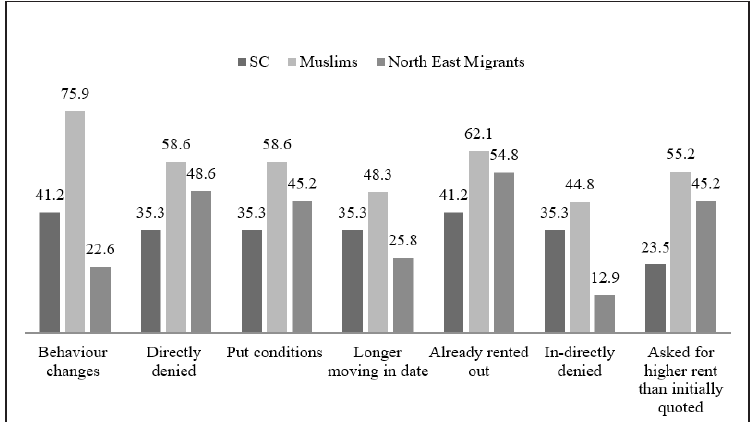
Fig 1. Nature of Response by House Owner Source: Primary Field Survey